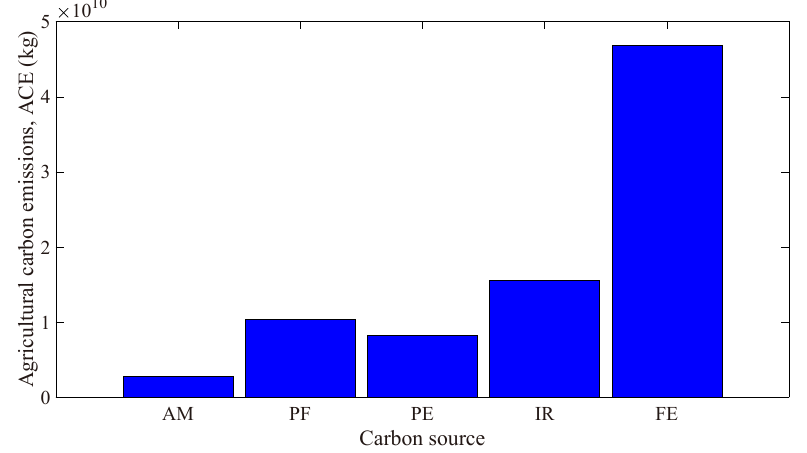
Figure 5. Agricultural carbon emission (ACE, kg) by carbon source,